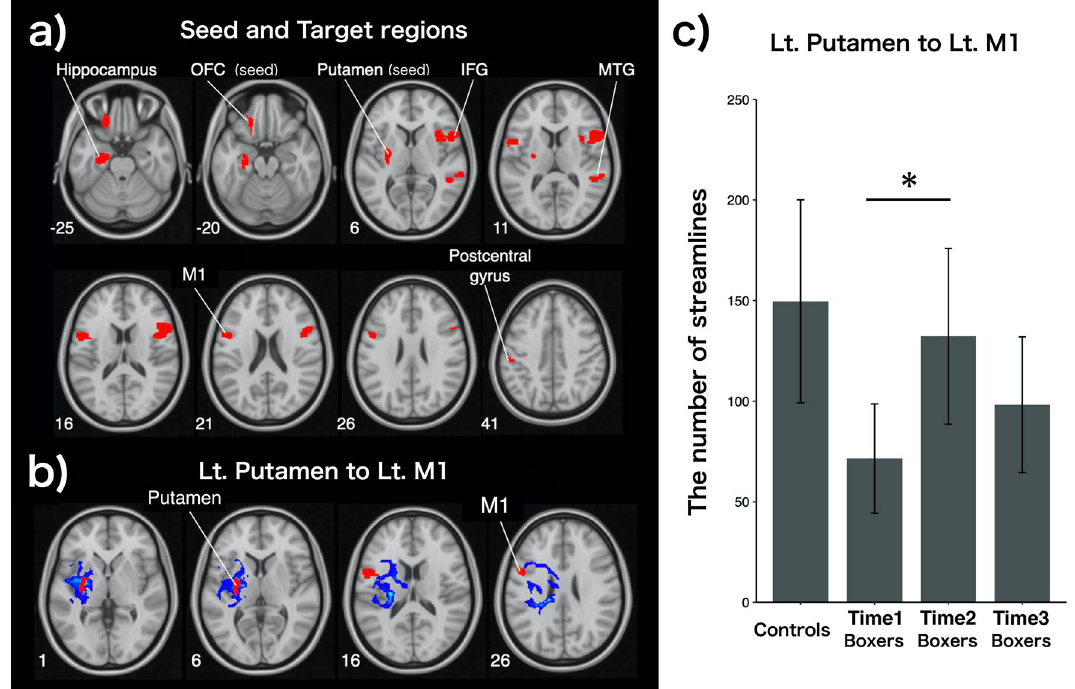
Figure 6. Diffusion tractography and the number of streamlines from the Lt. putamen to Lt. M1. ( a ) Seed and target brain regions used in diffusion tractography analysis are shown in red; These region-of-interests were defined based on the results from group-level analyses in the resting-state functional connectivity: from Lt. OFC (seed) to Lt. hippocampus and right MTG, and from Putamen (seed) to Lt. M1, Lt. postcentral gyrus and right IFG. b ) Representative images of tractography results from the Lt. Putamen to Lt. M1 for a subject, are illustrated. Streamlines were originally drawn in native space, and then were transformed into MNI space. ( c ) The number of streamlines from the Lt. putamen to Lt. M1 in controls and boxers (Time1, Time2, and Time3). Only the number of streamlines from Lt. putamen to Lt. M1 between Time1 and Time2 in boxers shows a significant increase [ F (2, 40) = 4.76, p = 0.02] in repeated measures ANOVA. Bonferroni correction was used in post-hoc analysis. Lt, left; OFC, orbitofrontal cortex; M1, primary motor cortex; MTG, middle temporal gyrus; IFG, inferior frontal gyrus; ANOVA, analysis of